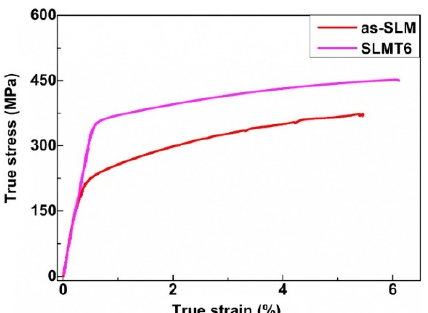
Figure 55. Tensile stress-strain curves of as-SLM and SLM T6 Al-3.5Cu-1.5Mg-1Si specimens [191].